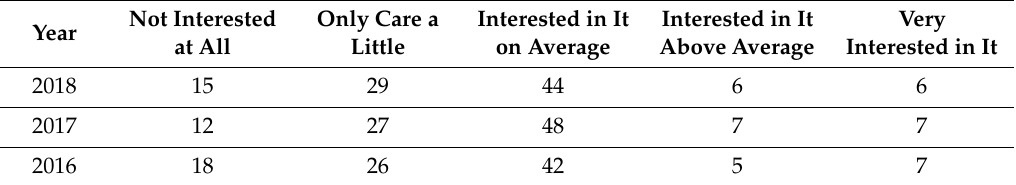
Table 3. What is your interest in information concerning the forests and the forest use? (data in %, source: A2016, A2017, A2018).